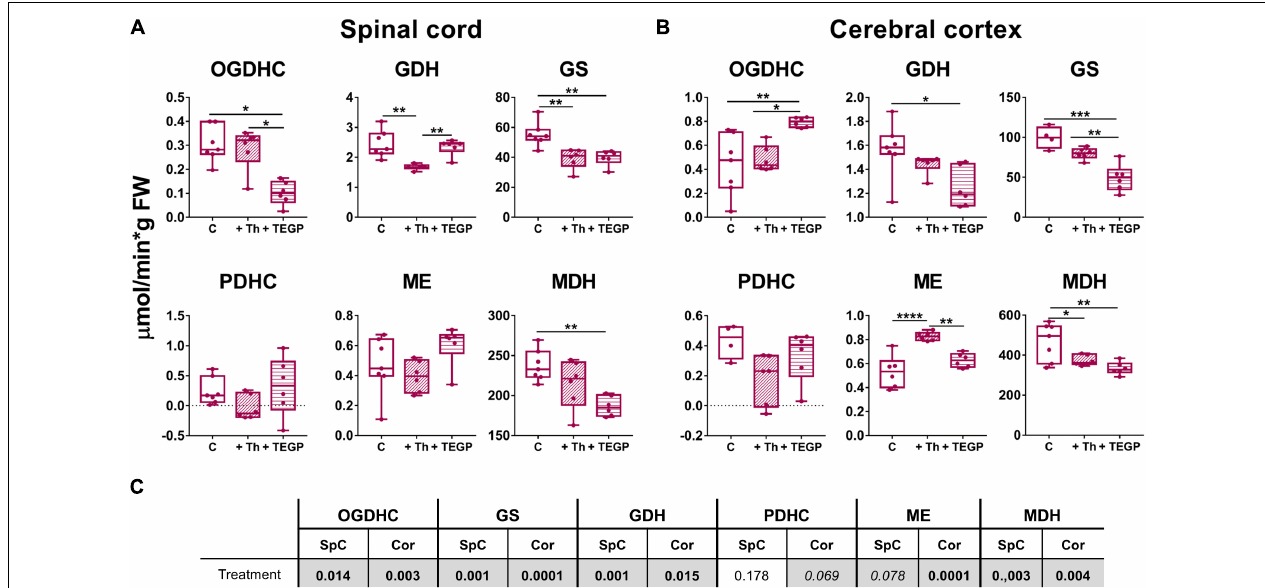
FIGURE 6 | Reactivities of OGDHC and affiliated enzymes to the thiamine or TEGP administration in the non-operated rats. (A) The enzymatic activities in the spinal cord (SpC), (B) The enzymatic activities in the cerebral cortex (Cor). (C) Significances ( p ≤ 0.05, in bold) and trends (0.05 < p ≤ 0.1, in italic) of the treatment factor, according to one-way ANOVA of the data in (A,B) , are highlighted in gray. Thiamine (Th, 1.2 mmol/kg intraperitoneally) or TEGP (0.02 mmol/kg intranasally) are administered to non-operated (control, C ) rats. On the graphs, different p -values are shown by asterisks as described in Methods under Statistical Analysis. Number of animals in each group: Ctrl, n ≥ 4; TEGP, n = 6; Th, n =